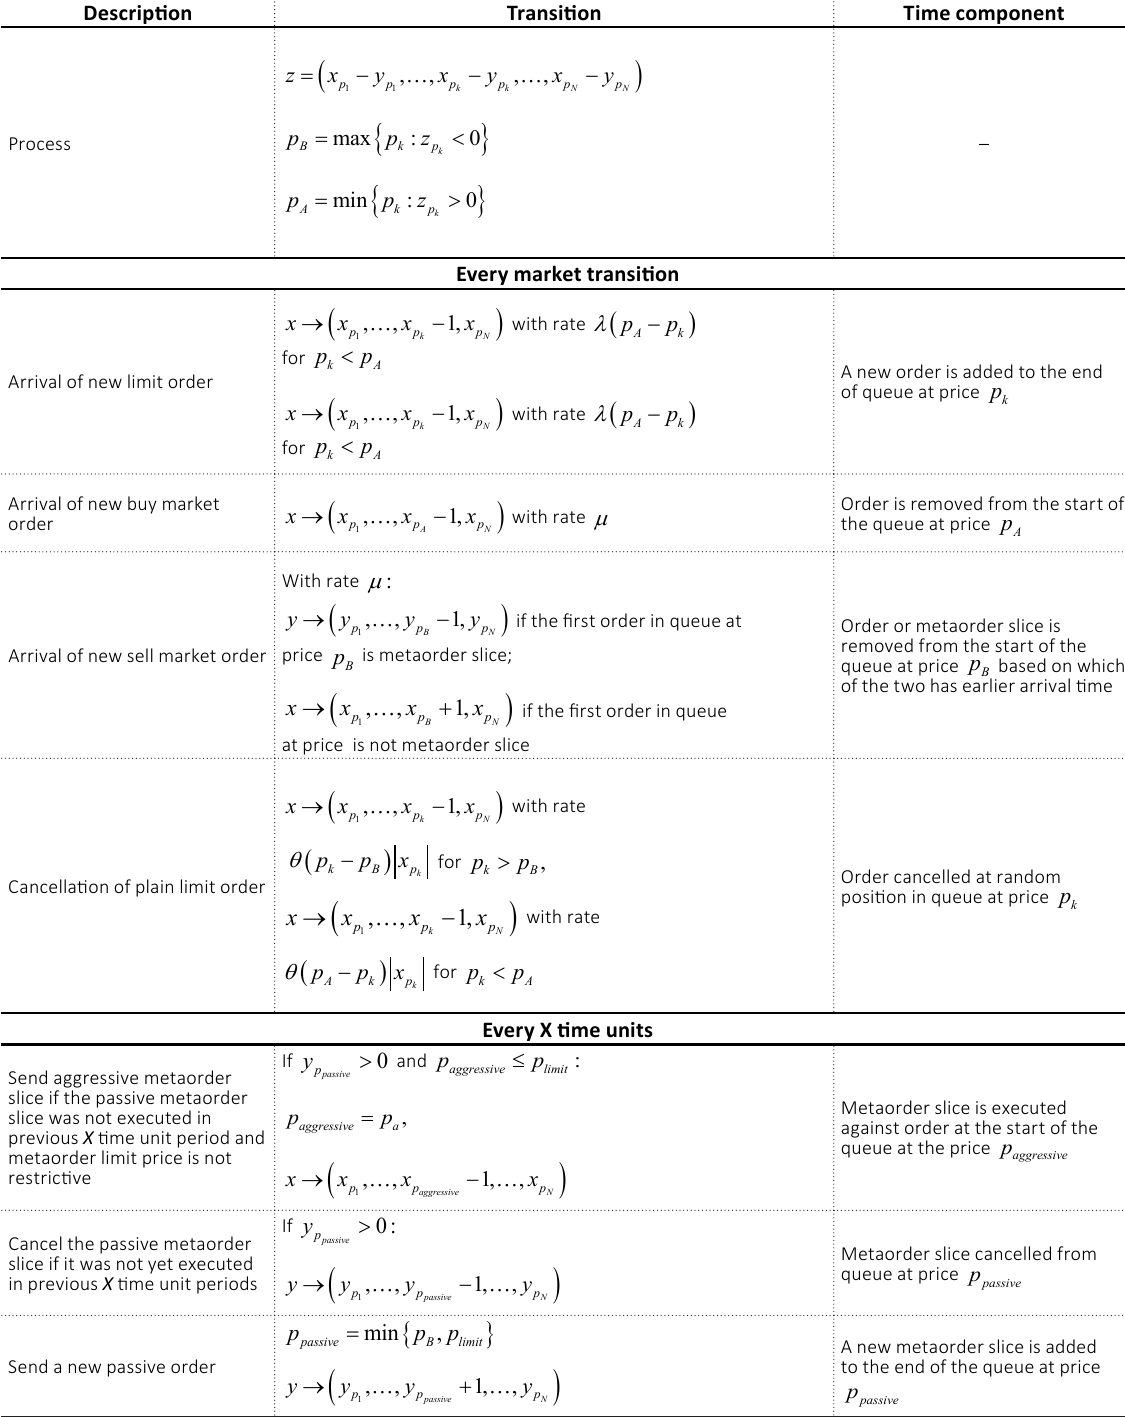
Table 1. Description of combined process